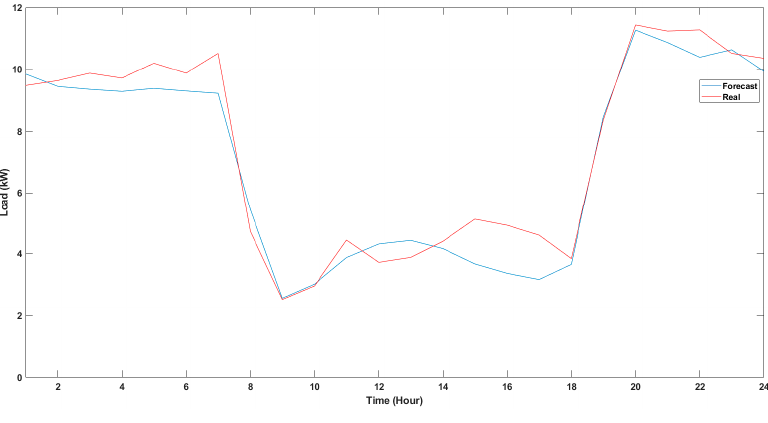
Figure 12. Forecasting and real PV power curves for 04/02/2019.